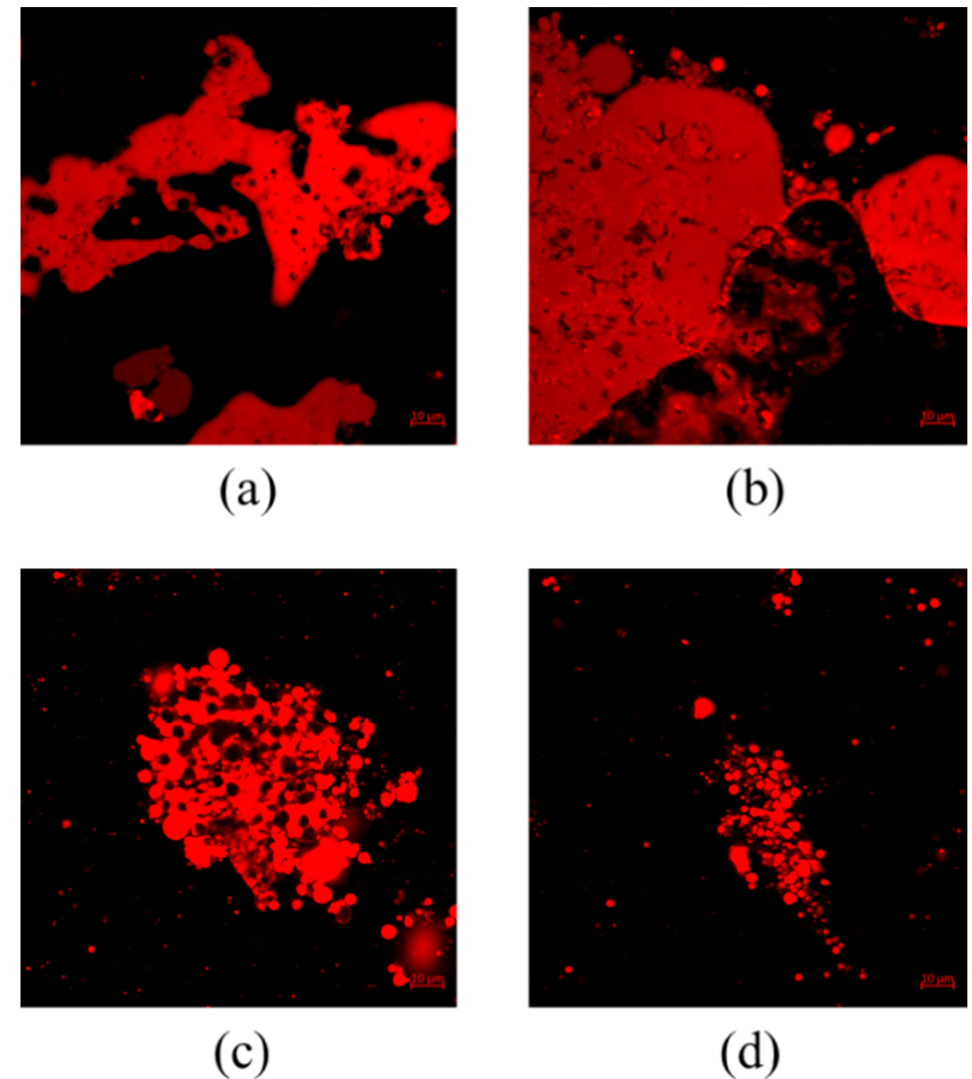
Figure 1. CLSM images of pumpkin seed milk droplets prepared with different pumpkin seeds: ( a ) raw pumpkin seeds, ( b ) pumpkin seeds roasted at 120 °C, ( c ) pumpkin seeds roasted at 160 °C, and ( d ) pumpkin seeds roasted at 200 °C.